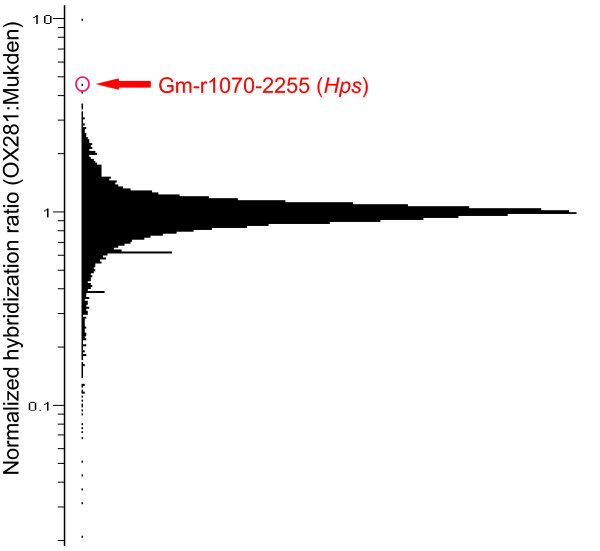
Microarray analysis of gene hybridization ratios comparing genomic DNA from soybean lines polymorphic for Hps. Genomic DNA samples from soybean cv Mukden and from line OX281 were individually labelled with fluorescent dyes Cy3 and Cy5, mixed, and hybridized to an 18 K array of soybean cDNAs. Genes from the array are plotted according to their normalized hybridization ratios (GeneSpring 7.2; Silicon Genetics, Redwood City, CA). The spot on the array corresponding to cDNA clone Gm-r1070-2255 encodes Hps. Data from a representative experiment is shown (Experiment II), where normalized hybridization values are averaged from separate hybridizations after swapping fluorescent dye labels for each genomic DNA sample.